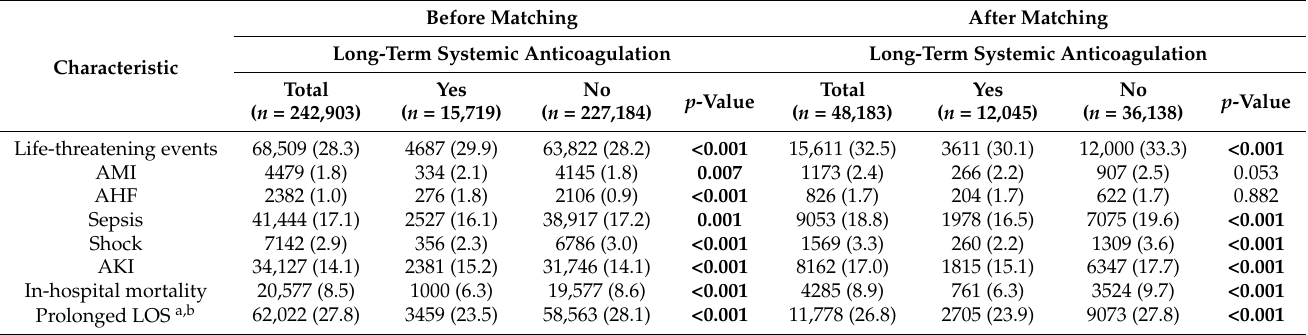
Table 2. Inpatient outcomes of patients with pancreatic cancer with or without long-term systemic anticoagulant use.